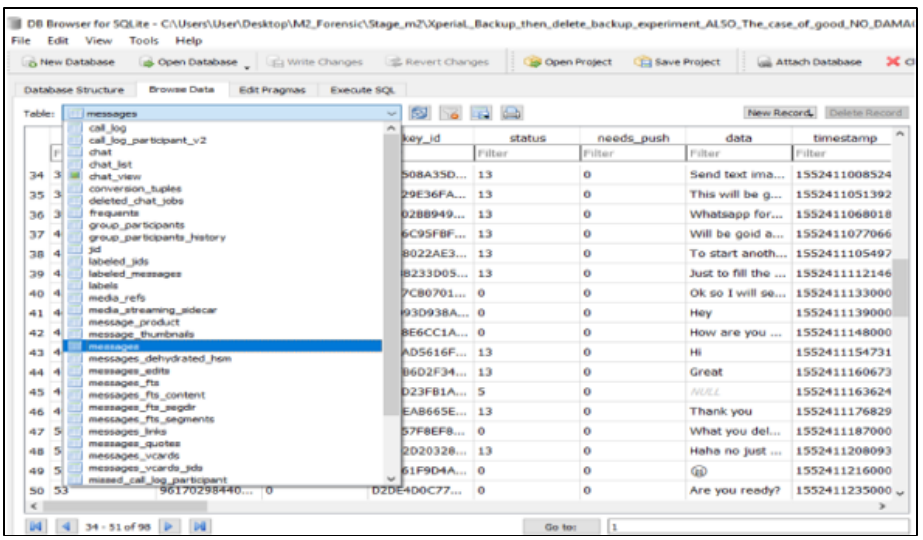
Figure 7. The decrypted database msgstore opened in DB Browser for SQLite Corrupted